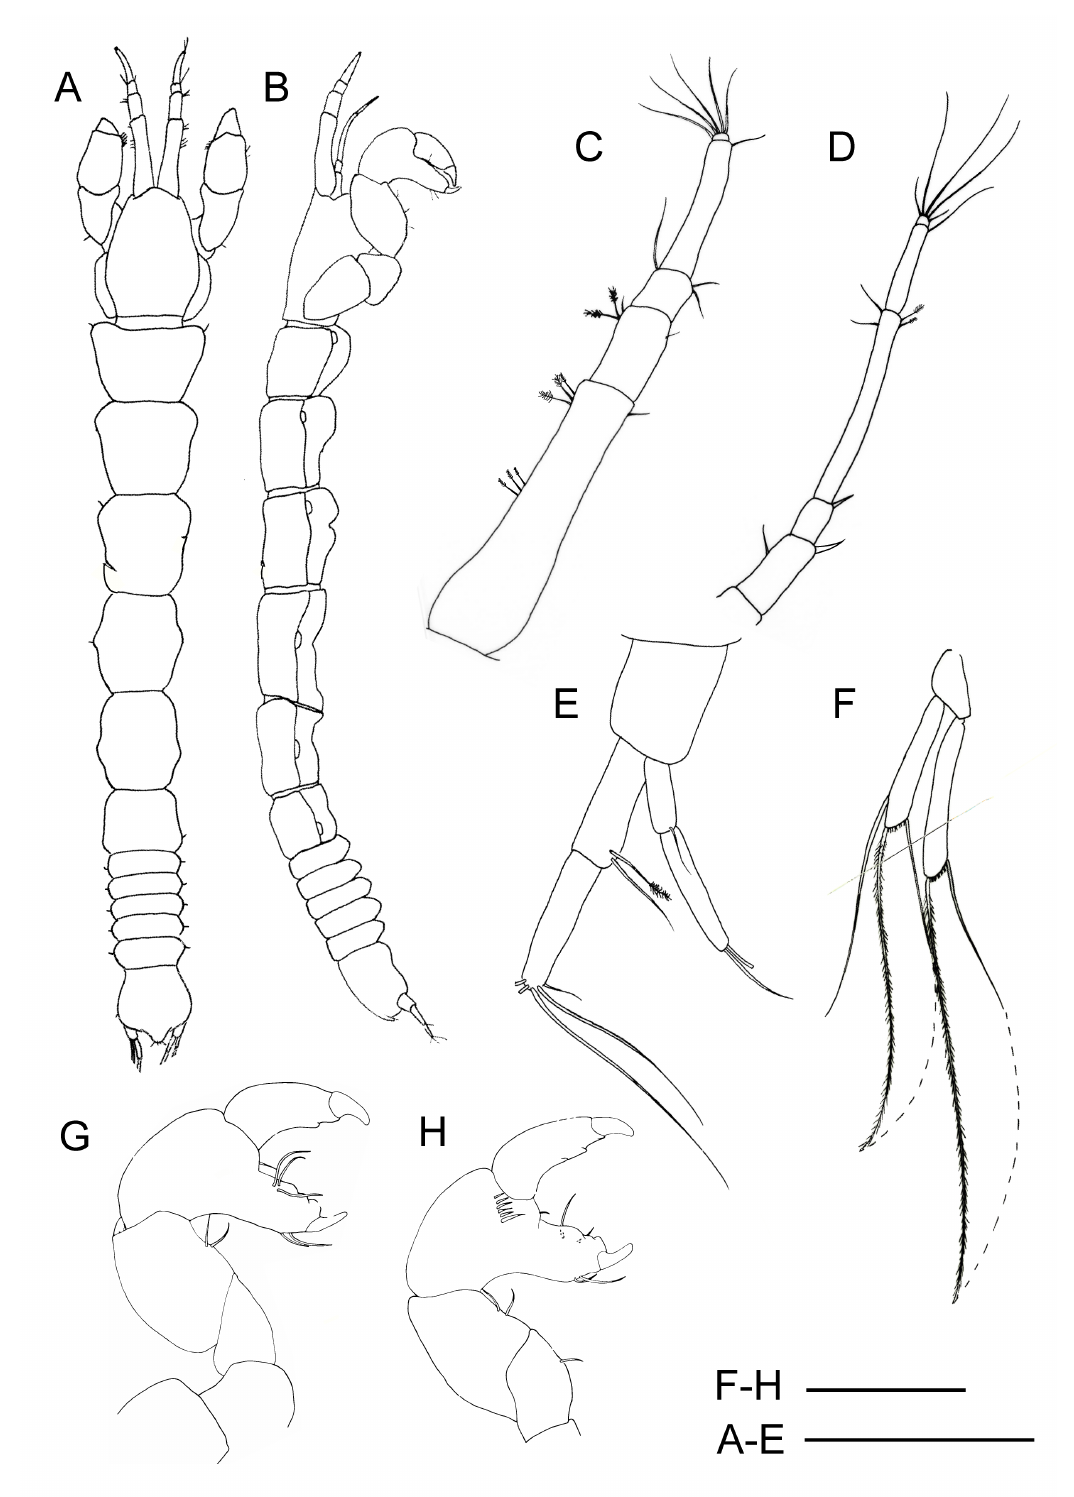
Fig. 6. Tirana vallis gen. et sp. nov. Holotype, adult, ♀ (MNCN 20.04/12540). A . Habitus dorsal view. B . Habitus lateral view. C . Left antennule, dorsal view. D . Right antenna, lateral view. E . Left uropod. F . Pleopod 3 (all setae are plumose). G . Left cheliped, outer view. H . Left cheliped, inner view. Scale bars: A–B = 1 mm; C–D, F–H = 100 μm; E = 50